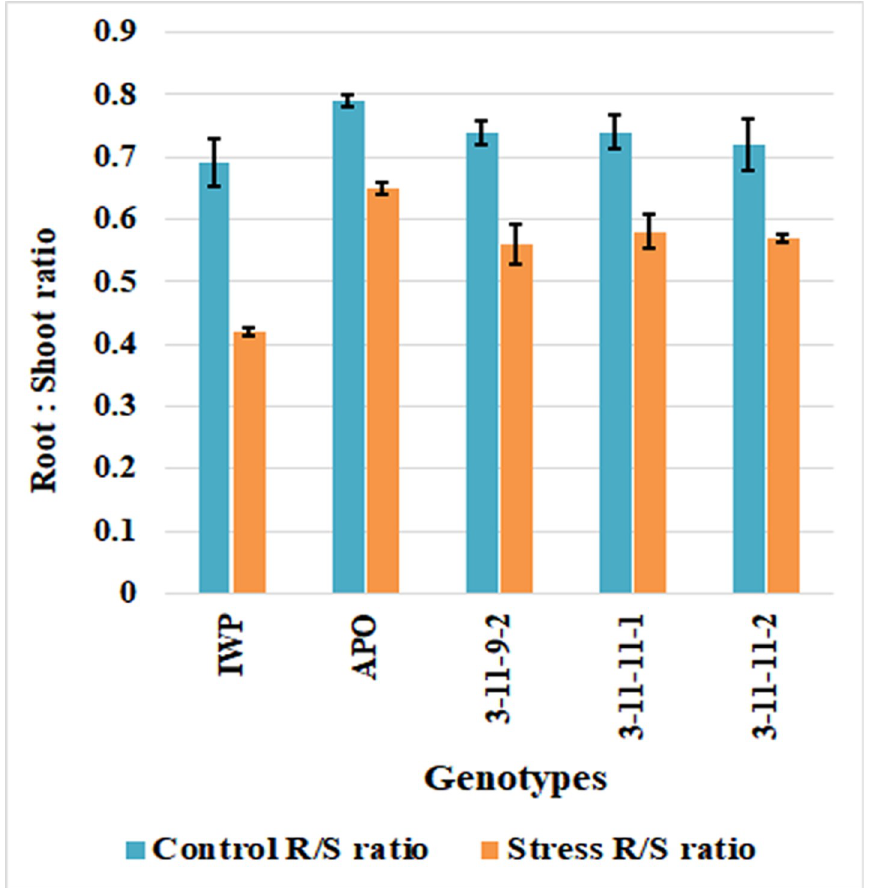
Fig 8. Differential response of BILs and parents under control and stress (-0.5 MPa PEG) conditions.